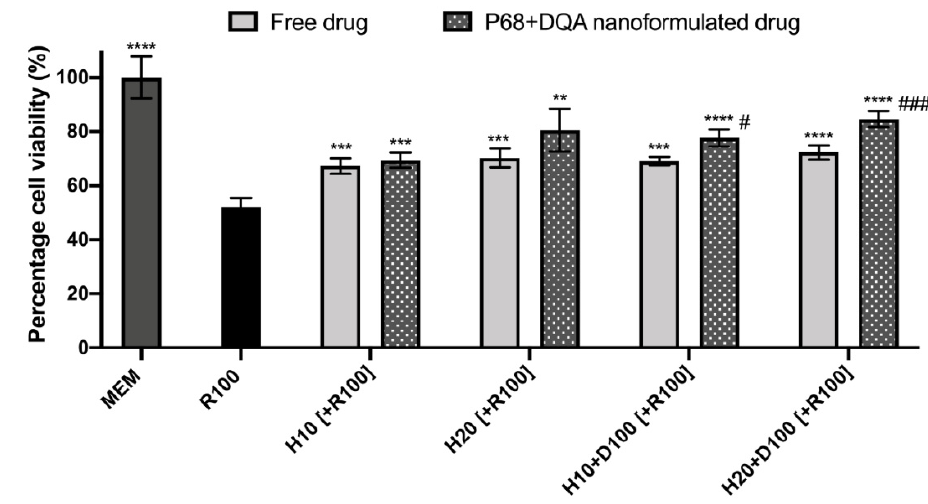
Figure 7. SH-SY5Y MTT assay results for free and P68 + DQA preparations of 10 and 20 µ M HT and combined HT and DF0 (10 or 20 µ M HT + 50 or 100 µ M DFO, respectively) following passage across the hCMEC/D3-SH-SY5Y co-culture Transwell ® system. The hCMEC/D3 cells were grown on the insert and the SH-SY5Y cells were located at the bottom of the basolateral compartment. Treatments were added to the apical compartment of the Transwell ® system and incubated for 3 h, the SH-SY5Y cells were then incubated with 100 µ M rotenone for 24 h. These results were compared to rotenone treatment alone. MEM represents the control condition where cells were only treated with media (mean ± S.D., n = 6). * represents significance values of control or pre-treatment conditions compared to rotenone treatment alone (**** p < 0.0001, *** p < 0.001, ** p < 0.01). # represents significance values of nanoformulated drug compared to free drug within the same treatment condition (### p < 0.001, # p <